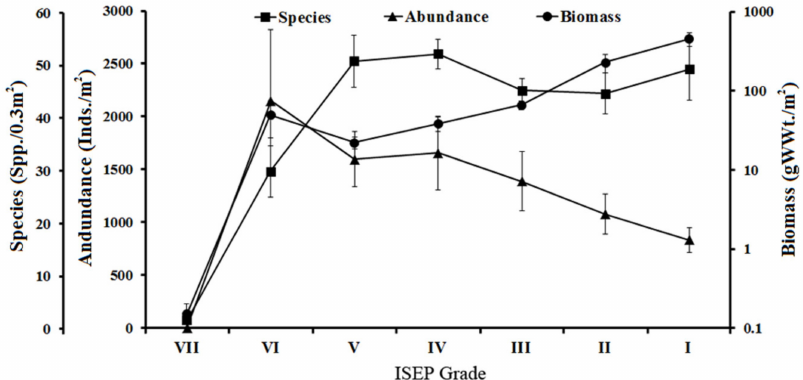
Figure 4. Overall pattern of SAB (species-abundance-biomass) variation in the macrofaunal commu- nity along ISEP grades observed along the west coast of Korea. ISEP grades are shown on the x -axis from low quality (grade VII) to high quality (grade I), from left to right, to allow comparison with the P-R model. Note that biomass is presented on a logarithmic scale. The points are averages, and the vertical bars represent the standard